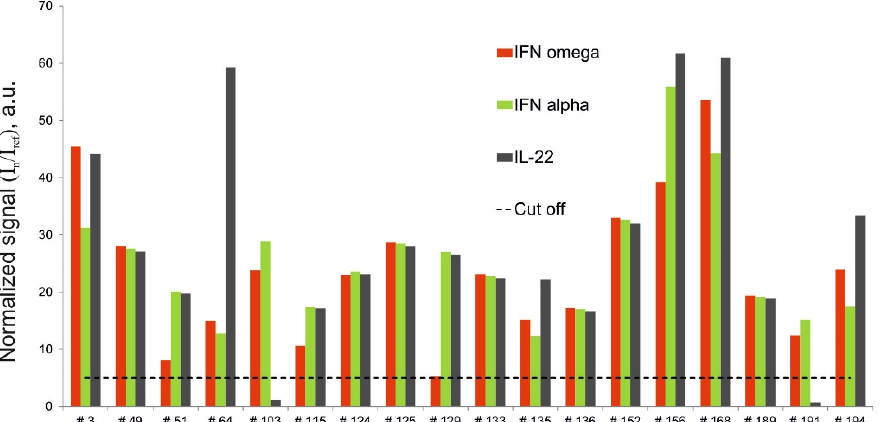
Figure 2. Normalized signals for autoantibodies against IFN- ω , IFN- α -2a and IL-22 in serum samples from APS-1 patients, as determined by the microarray-based assay.